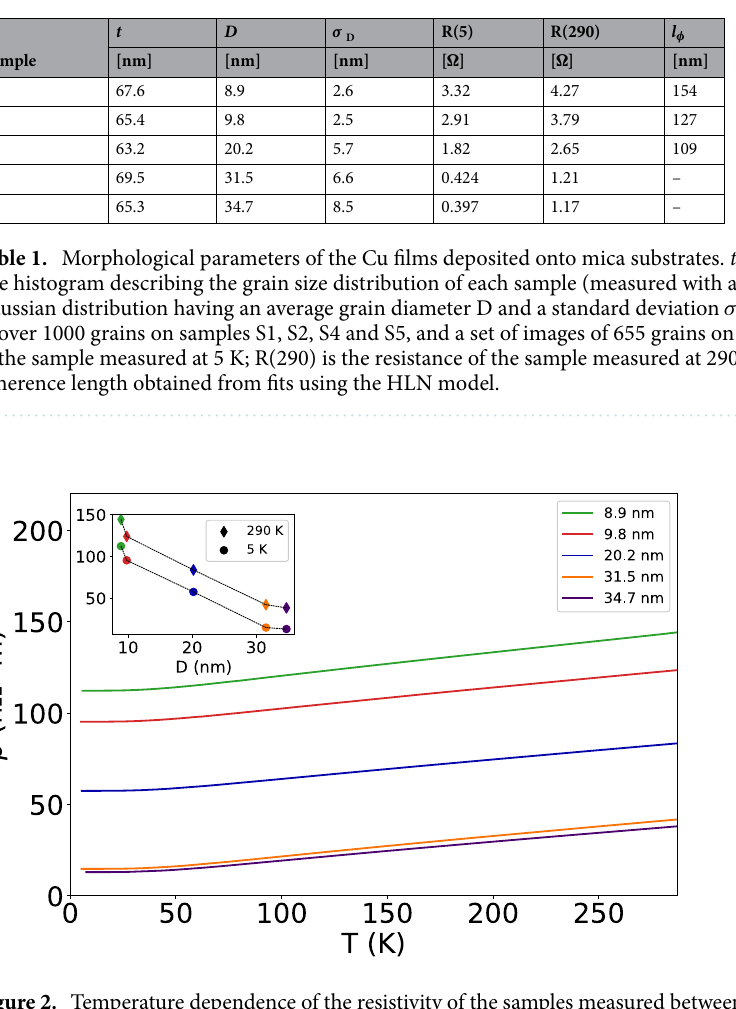
Figure 2. Temperature dependence of the resistivity of the samples measured between 5 and 290 K. In the inset is displayed the resistivity of the samples measured at 5 K and at 290 K, plotted as a function of the mean grain diameter D